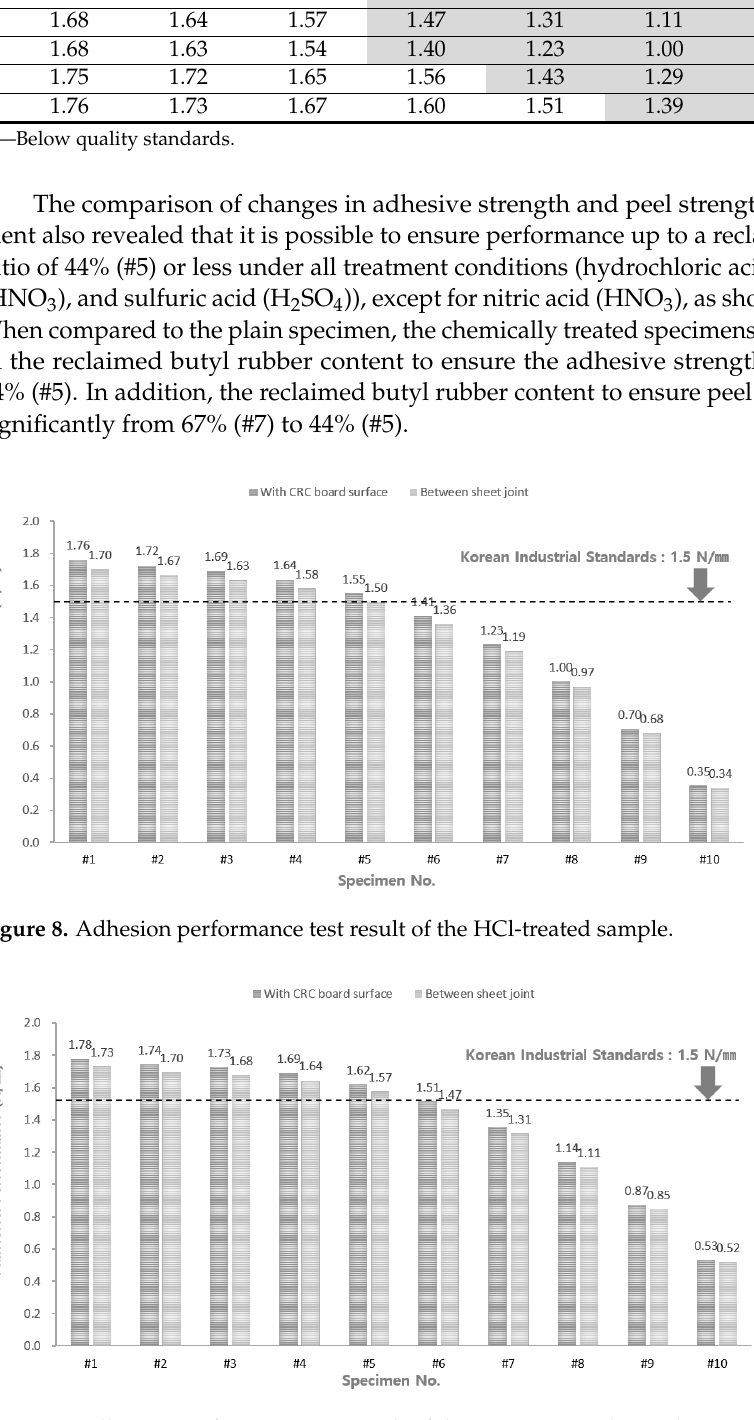
Figure 9. Adhesion performance test result of the HNO 3 -treated sample.